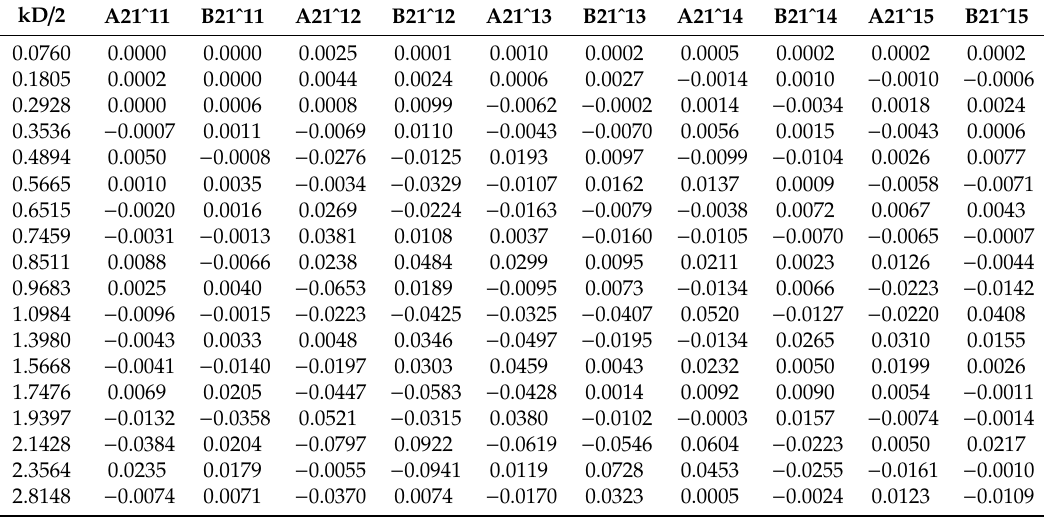
Table A5. Hydrodynamic characteristics of the 1st floater of the array of five conical